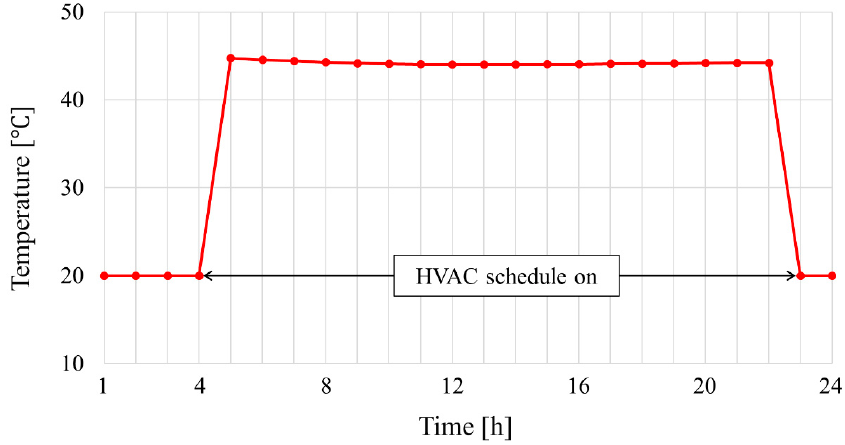
Figure 10. Variation in solution temperature of the sump on a peak day.